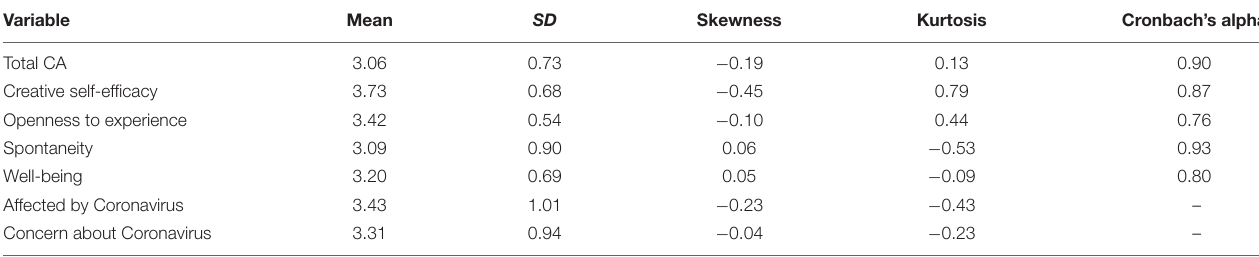
TABLE 2 | Descriptive statistics and reliability analyses for study